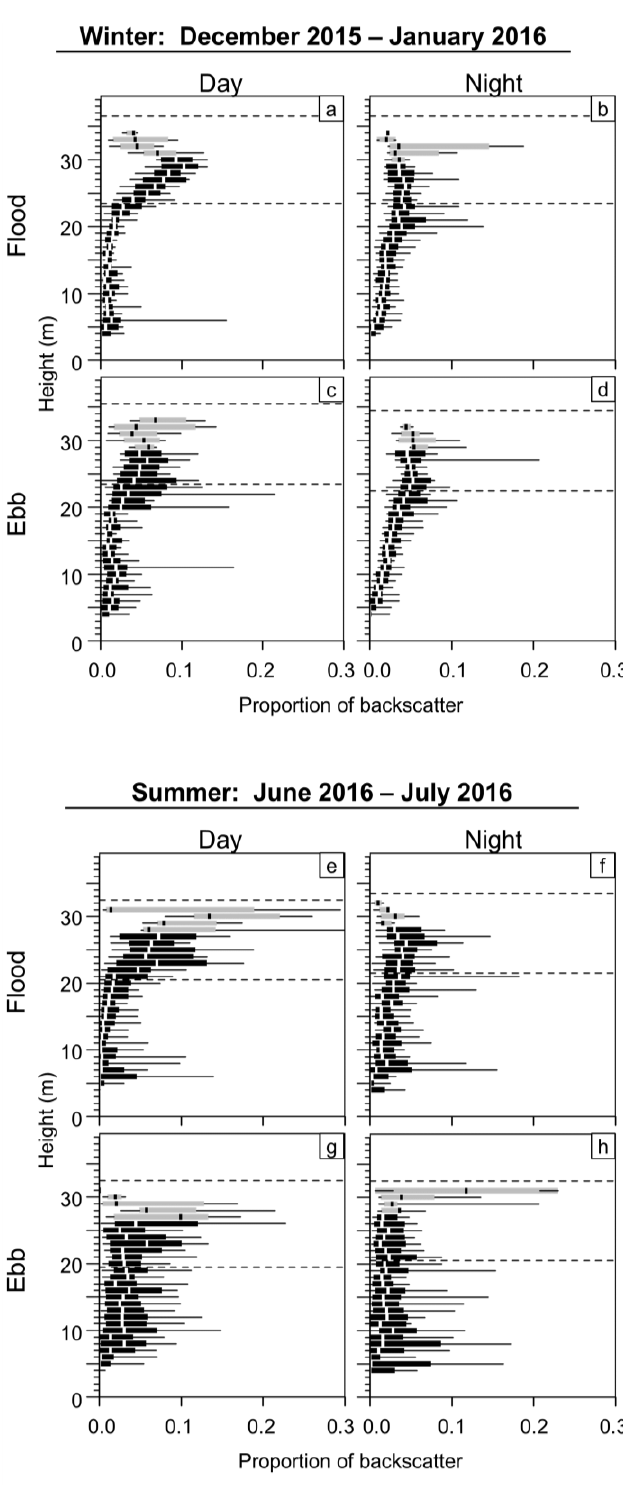
Fig. 7 Vertical distribution of area backscatter during time periods of interest, from the winter (a-d) and summer (e-h) datasets. Thick vertical Fig. 6 Water column mean volume backscatter, S V (proportional to fish lines indicate median, boxes encompass the interquartile range, and whiskers density). (a) Winter vs. summer. (b) Day vs. night in winter and summer. span the 10th to 90th percentiles of each 1-m layer of the water column. Sample sizes are shown at top. Letters indicate groups with significantly Grey boxes indicate sample sizes less than 10. Horizontal dashed lines are different means (a highest, b lowest), where tested. White diamonds are the minimum and maximum height of the analysed water column (which means, horizontal bars are medians, boxes span 25 th to 75 th percentiles, and extended upward to 10 m below the true surface) for the duration of each whiskers span 10 th to 90 th time period. Height is measured upward from the sea floor.